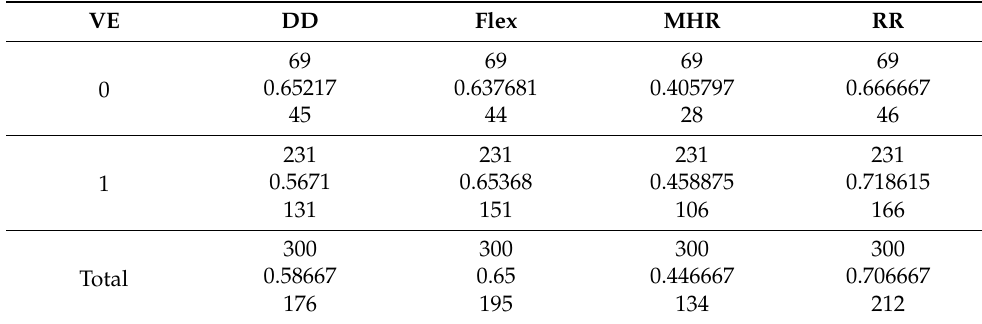
Table 3. Pairwise counts, sums and means grouped by